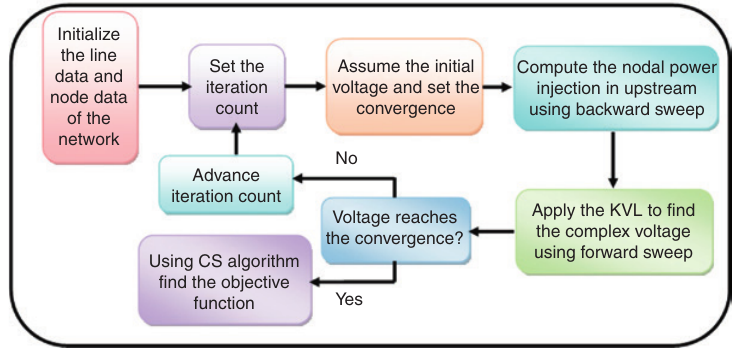
Figure 1: Load Flow Analysis of the Distribution System Using the Proposed